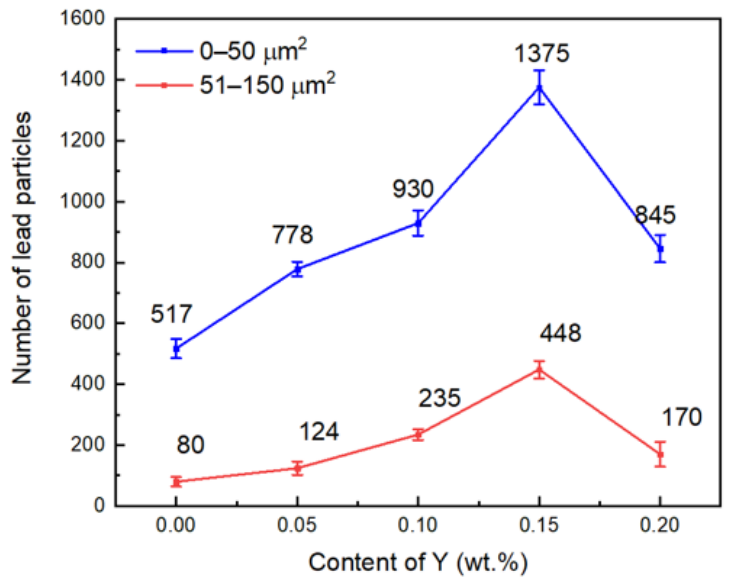
Figure 6. Changes in the number and size of lead particles with increasing Y content.